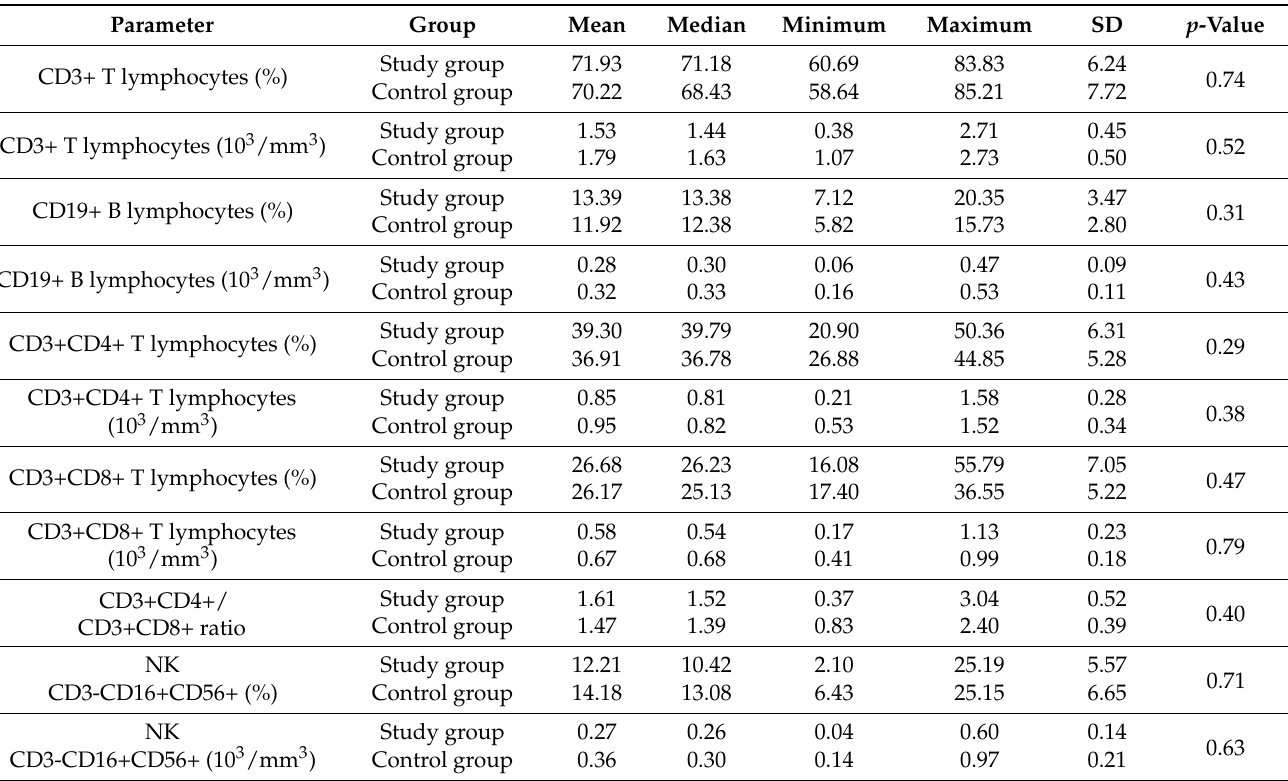
Table 1. Percentage and absolute values of selected subpopulations of lymphocytes in the study group and in the control group.